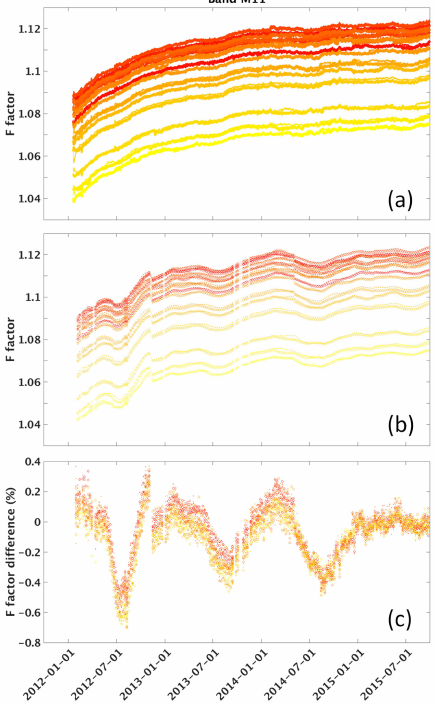
Figure A8. ( a ) VIIRS band M11 (2250 nm, single gain) radiometric calibration scaling coefficients (the F factors) derived by the automated calibration procedure; ( b ) the F factors used in the operational production of the VIIRS SDR; and ( c ) relative difference between the operational F factors and the reprocessed ones (used here as a baseline). Symbol legend is the same as in Figure 4.